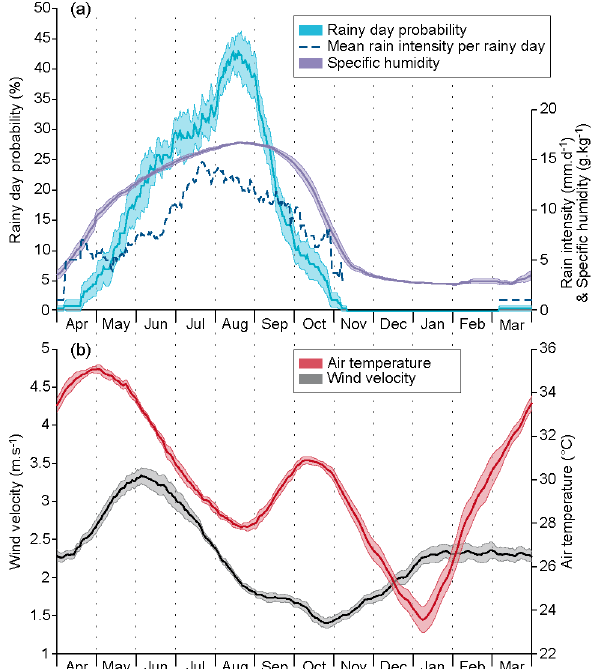
Figure 2. Mean seasonal courses of meteorological variables in Wankama catchment: (a) probability and mean rain intensity of a rainy day and specific humidity; (b) air temperature and 3m wind velocity. Values are 30-day running averages for 2005–2012, from instruments described in Table 1. Light-colored intervals represent a variation of ± 1 standard estimation